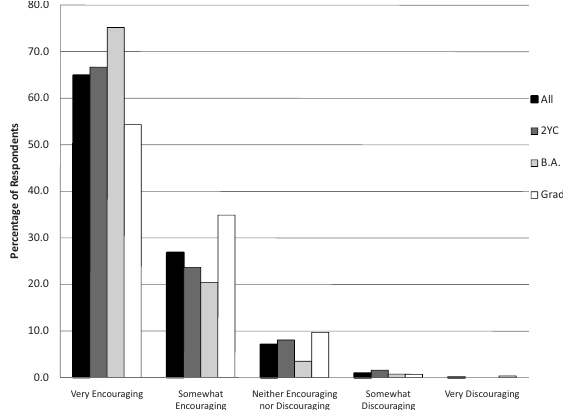
FIG. 1. Respondent perception of departmental environment to- ward teaching